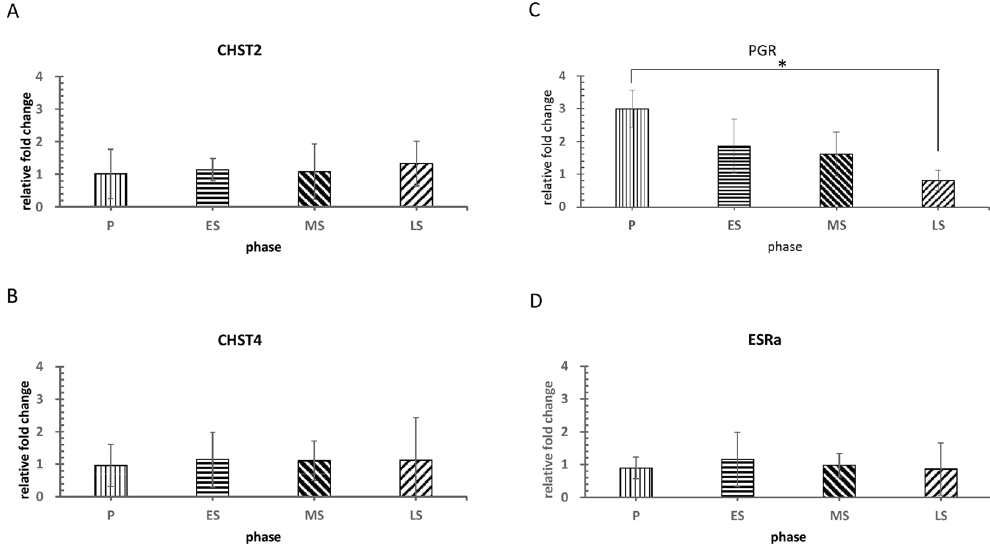
Figure 4. The expression patterns of CHST2, CHST4, ESR α and PGR genes in the four phases of the menstrual cycle. The gene expression of CHST2 and CHST4 was steady among the four phases ( A and B ). ESR α also revealed relatively stable expression among the four phases ( D ). PGR expression gradually decreased from the proliferative to the late-secretory phase. There is a significant difference between proliferative and late-secretory phases (P < 0.05) ( C ). Results are expressed as mean ± SE. Statistical significance was assessed by the Kruskal- Wallis test ( * p < 0.05). CHST2: carbohydrate sulfotransferase 2; CHST4: carbohydrate sulfotransferase 4; ESR α : estrogen receptor α ; PGR: progesterone